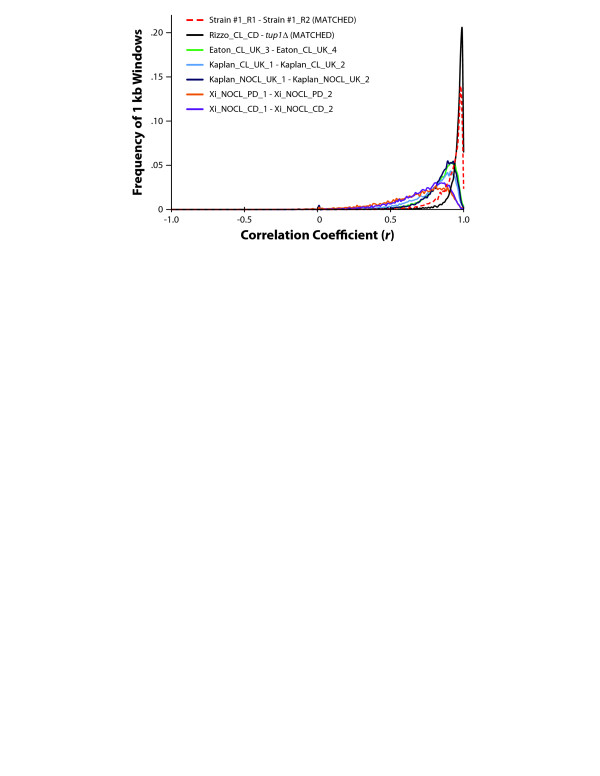
Matched samples yield fewer dissimilar regions of chromatin. Histogram illustrating the frequency of Pearson correlations (r) for comparisons between MNase-seq datasets for all tiling 1000 bp windows across the S. cerevisiae genome at 10 bp resolution. Comparisons were made between biological replicates, including our matched digest experiment (Strain #1 R1 & R2; red dotted line) and other published wild-type replicates (see Additional file 2: Table S1 for experimental details and references). Additionally, a comparison of matched wild-type and tup1Δ MNase-seq data is also illustrated (black). Results demonstrate how our matched preparation consistently produces MNase-seq datasets that are more closely correlated than other unstandardized preparations.